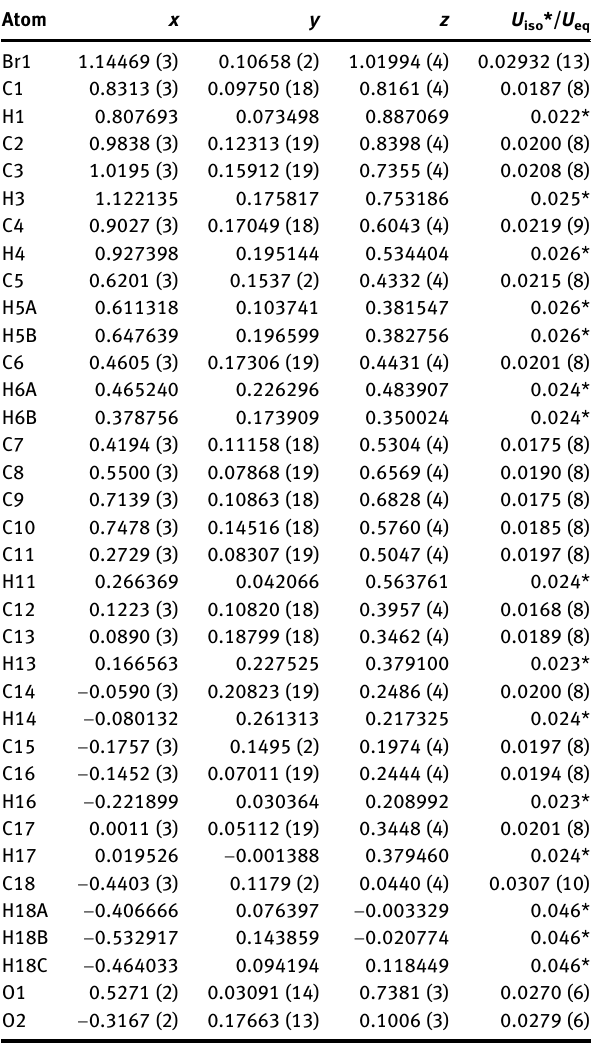
Table  : Fractional atomic coordinates and isotropic or equivalent isotropic displacement parameters (Å 